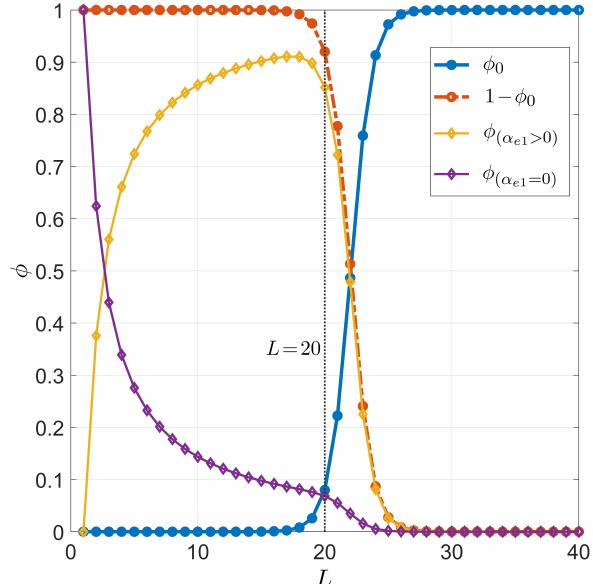
Figure 3. Dependence on the primer length L of the pairing probability for PCR. Fixed values are considered for temperature T = 55 ◦ C, total sites L 0 = 6 × 10 9 , salt concentration [ Na + ] = 55 mM, and for CG fraction n CG = L /2. Successful target binding ( φ 0 , blue dots). Off-target binding (1 − φ 0 , red dots). Off-target binding can be split into 2 contributions: off-target binding with no terminal defects at the 3 (cid:48) end ( φ ( α , purple diamonds), off-target binding with terminal defects at the 3 (cid:48) end e 1 = 0 ) ( φ ( α , yellow diamonds). The vertical gray line stands for L = 20, a typical primer length in PCR. e 1 > 0 )